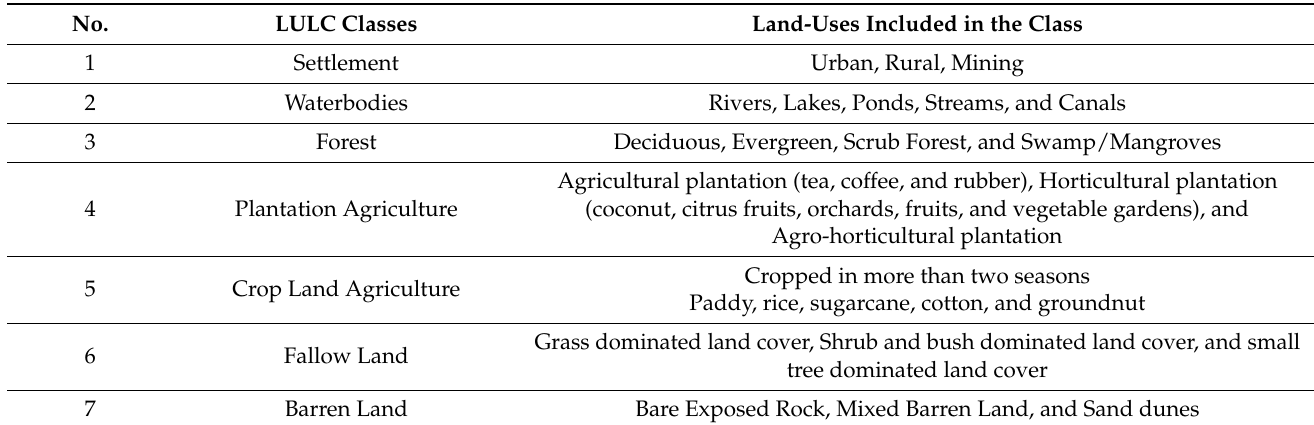
Table 2. Description of Landuse and Landcover (LULC)